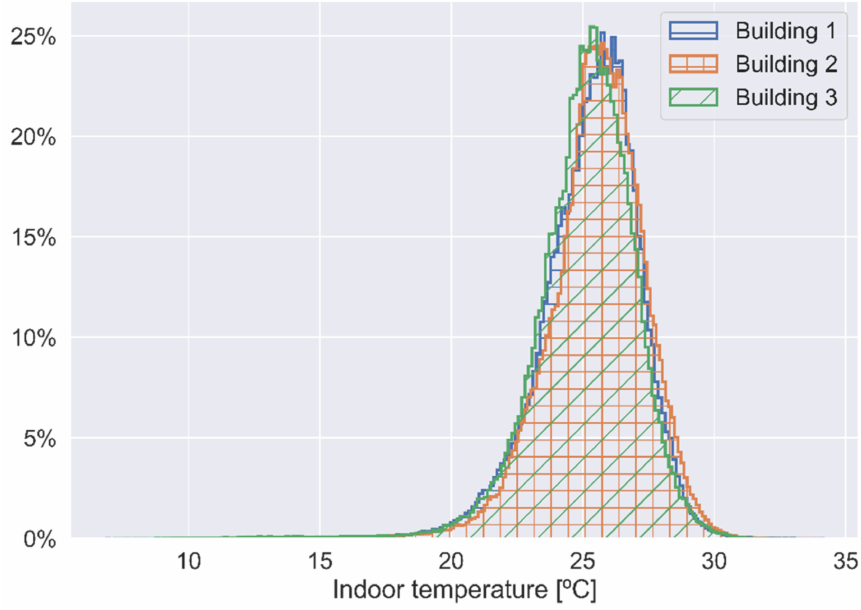
Figure 27. Probability density of indoor temperature from all apartments over 12